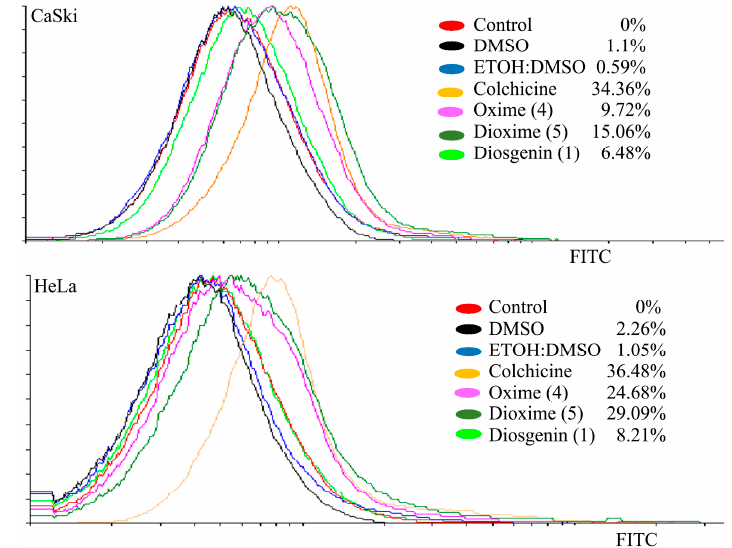
Figure 6. Induction of active caspase-3 by compounds 1 , 4 , and 5 on HeLa and CaSki cell cultures.